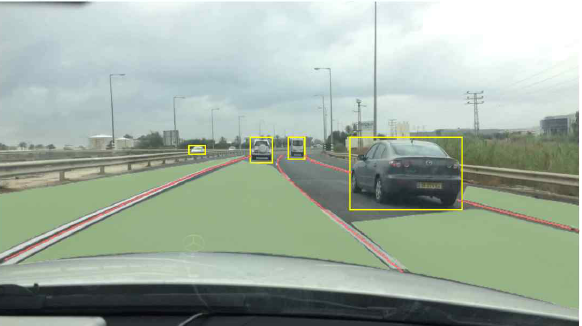
Figure 1. An example of three tasks; traffic object detection, drivable area segmentation, and lane line